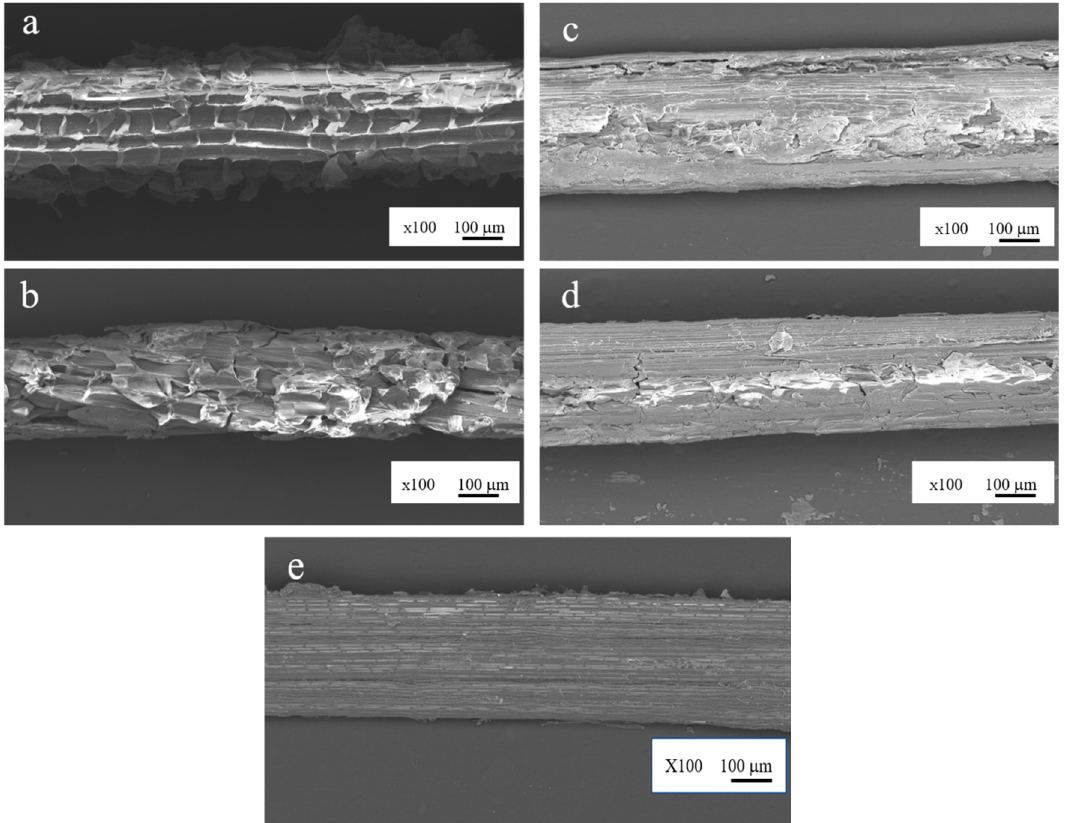
Figure 5. Surface imaging of ( a ) untreated, ( b ) Alkali-treated for 1 h, ( c ) Alkali-treated for 2 h, ( d ) Alkali-treated for 4 h, and ( e ) Alkali-treated for 8 h Typha spp . fibers.